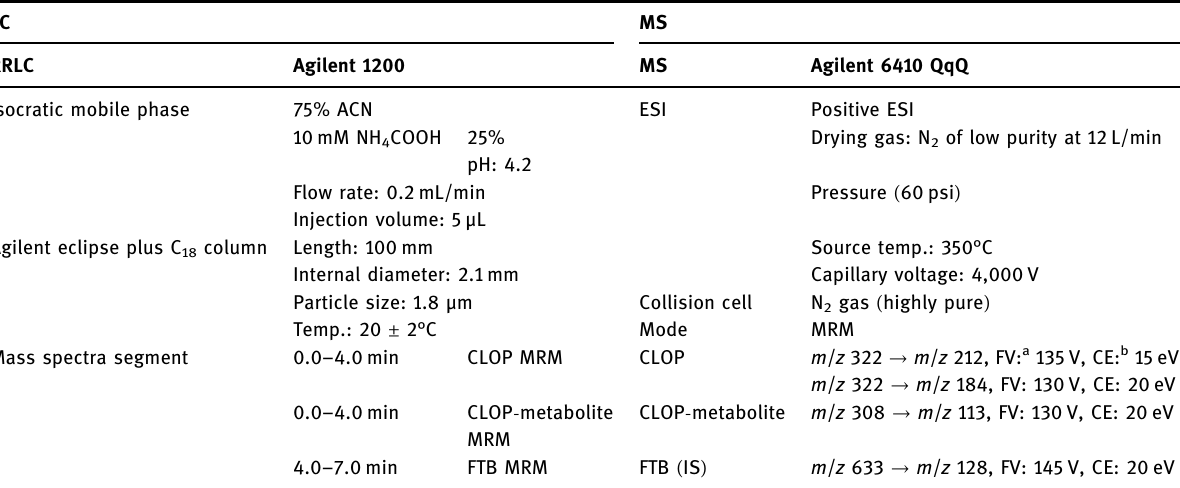
Table 1: LC - MS/MS analytical parameters LC